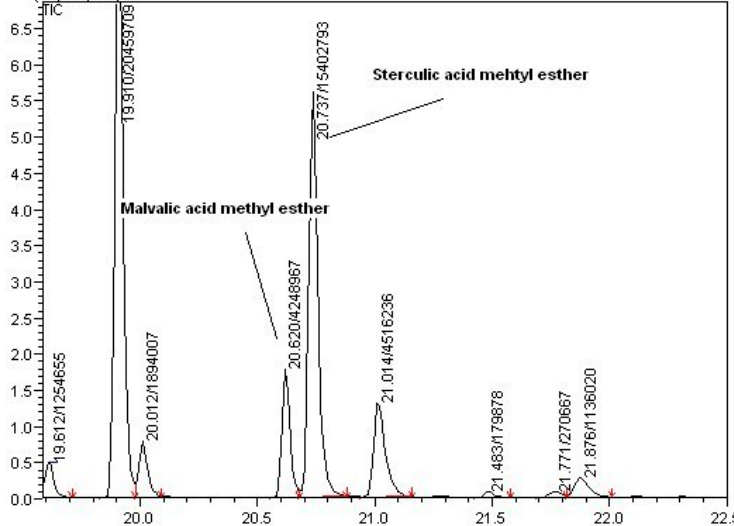
Figure 5. Spectrum of Gas Chromatography to detect the fatty acids present in Sterculia seeds with focus on malvalic and sterculic acids values of the area under the peak of the gas chromatogram. Sterculia apetala seeds are a good source of fatty acids and, in particular, palmitic acids between the others with a percent value of 39% on the total amount of fatty acids followed by oleic (23%), sterculic (20%) and malvalic (7%) (Herrera-Meza et al. found a composition of palmitic (19%), oleic (9.5%), sterculic (56%) and malvalic (1.3%) acids in roasted seeds of Sterculia apetala [14]).